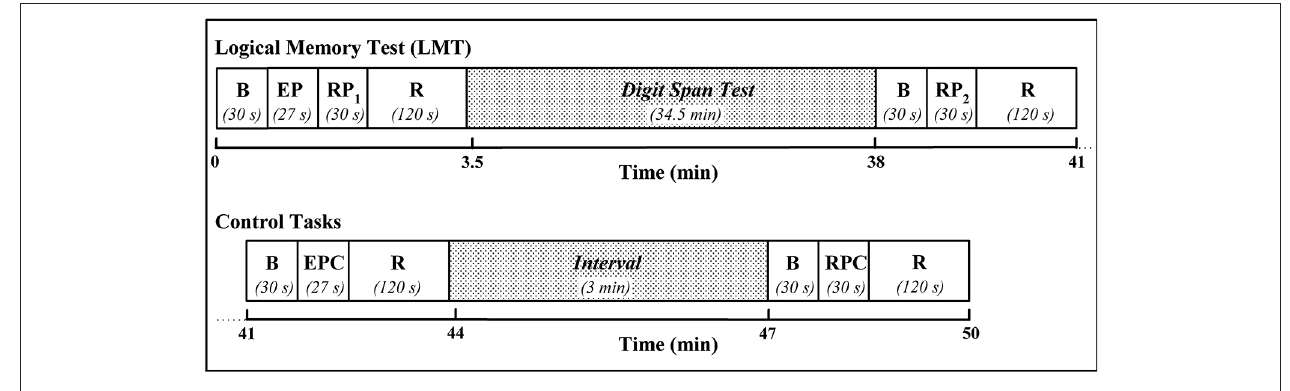
EPC: encoding process control (subjects’ verbal presentation of the backward LMT-story); RPC: retrieval process control (subjects’ week day aloud sentence